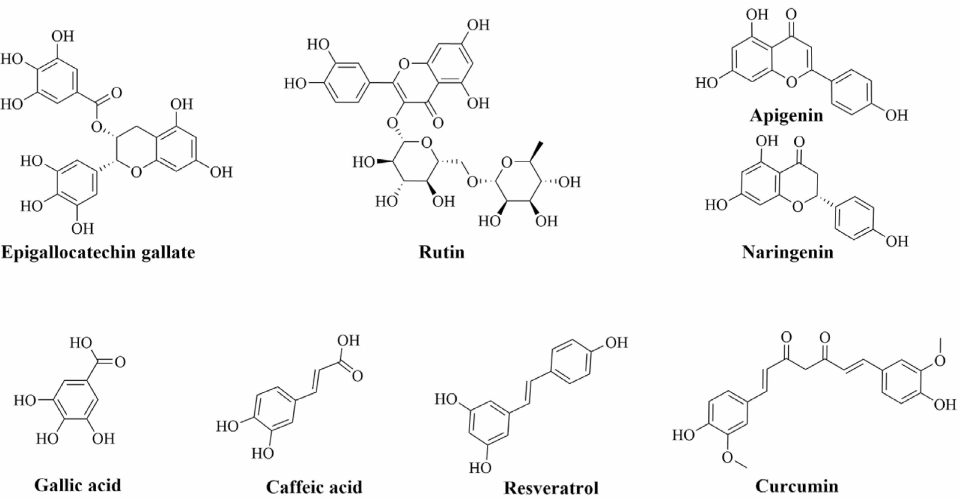
Figure 1. The common natural phenolic compounds studied in this